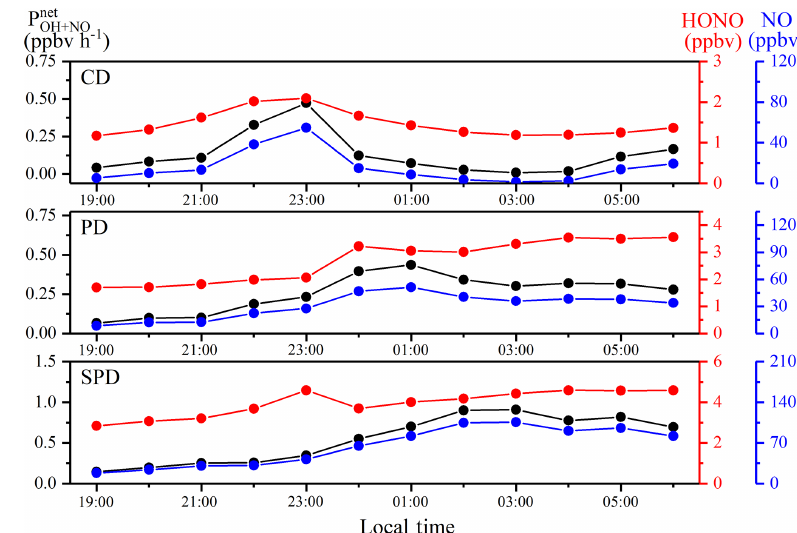
Figure 5. Nocturnal variations of P net